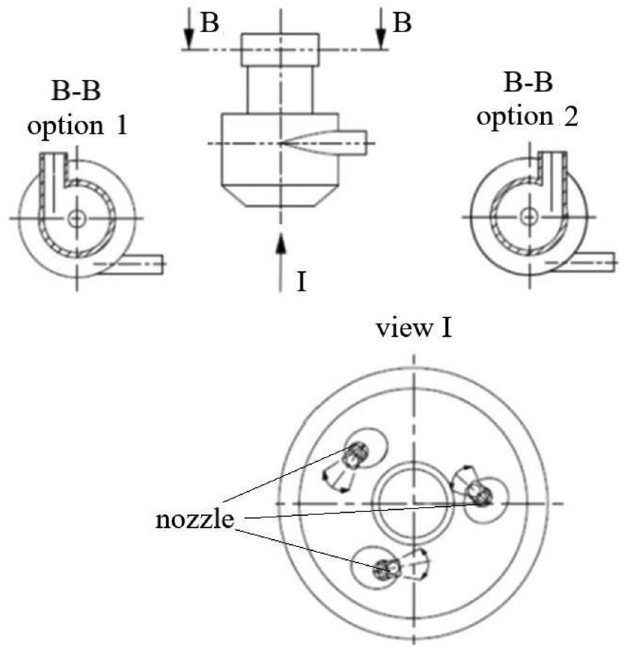
Fig. 2. Drawing of cavitation generating head with water removal system.